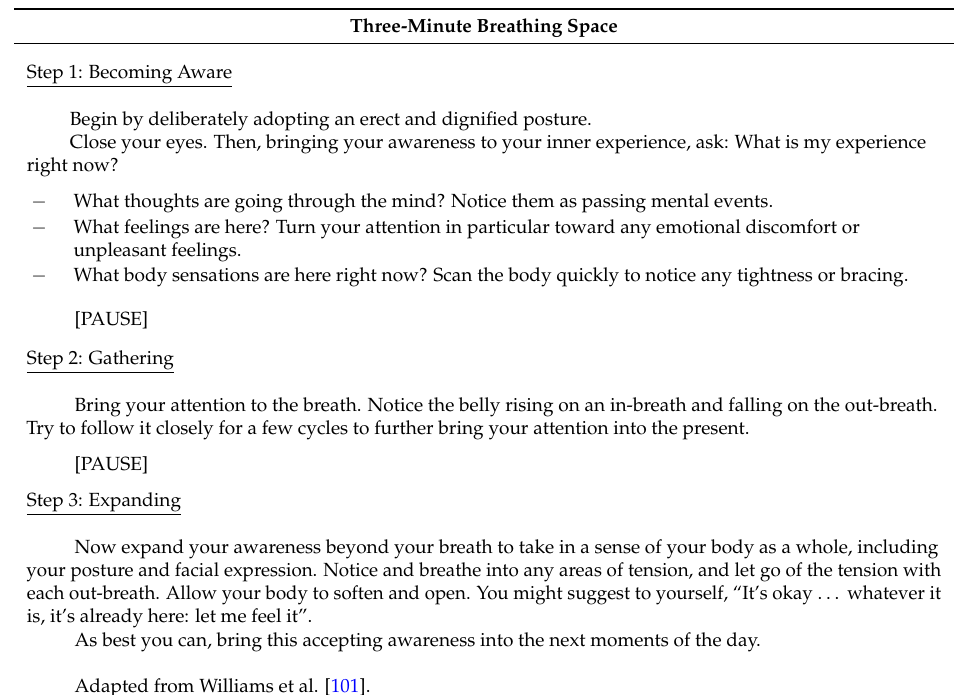
Table 4. Three-minute breathing